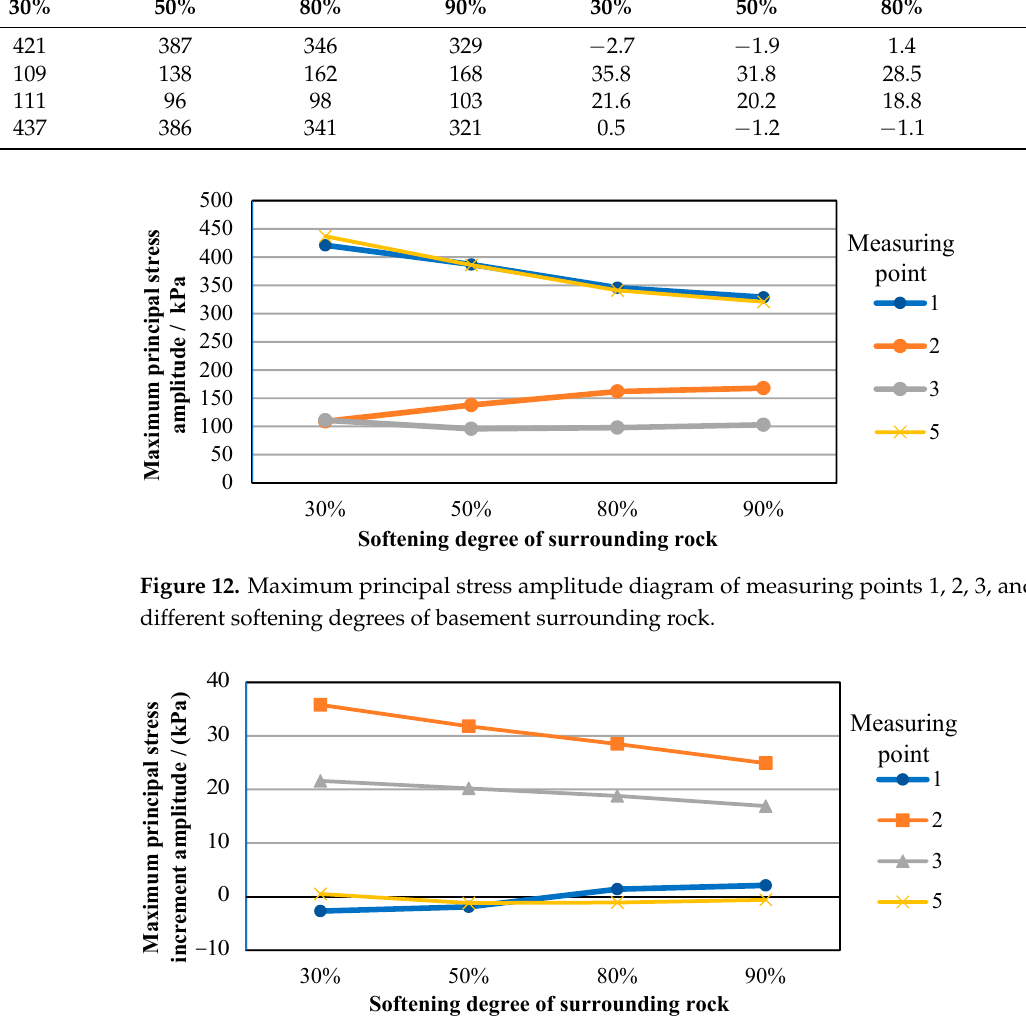
Figure 13. Maximum principal stress increment amplitude of measuring points 1, 2, 3, and 5 under different softening degrees of basement surrounding rock.